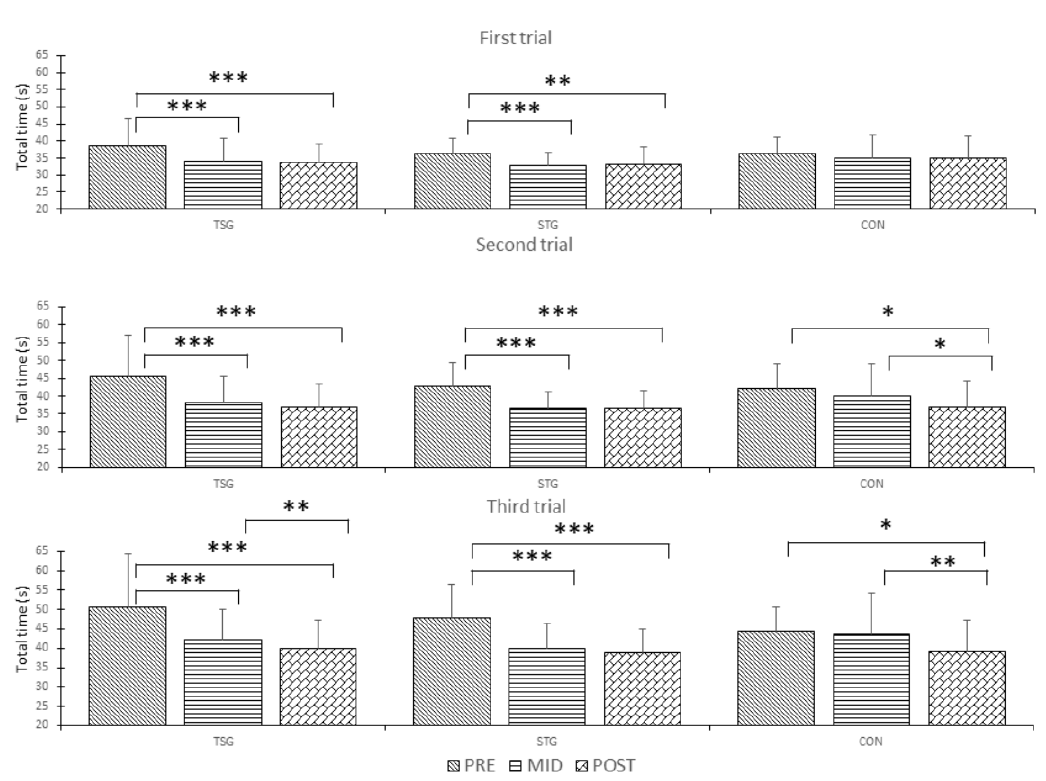
Figure 3. Total time (s) in the simulated military task course (first, second, and third trial). STG = strength training group; TSG = soldier task specific group; CON = control group; * = p < 0.05, ** = p < 0.01, *** = p <